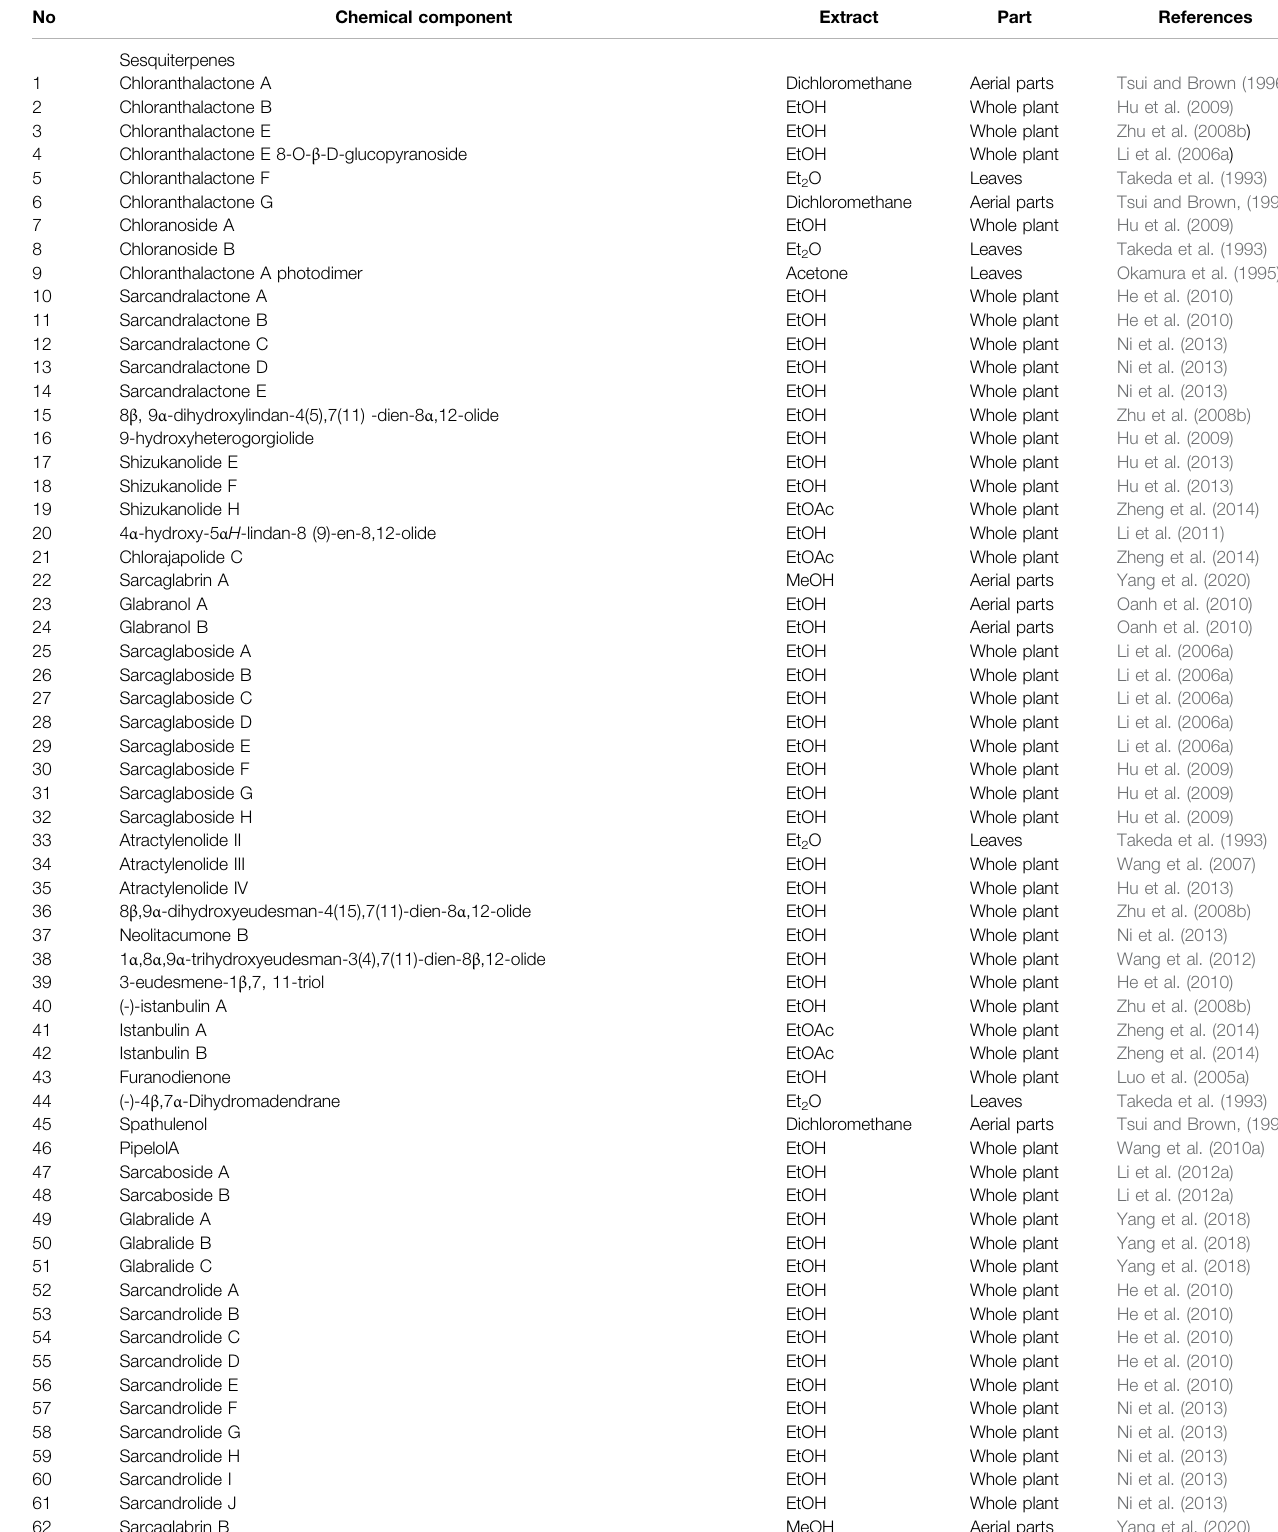
TABLE 1 | Compounds presenting in S. glabra